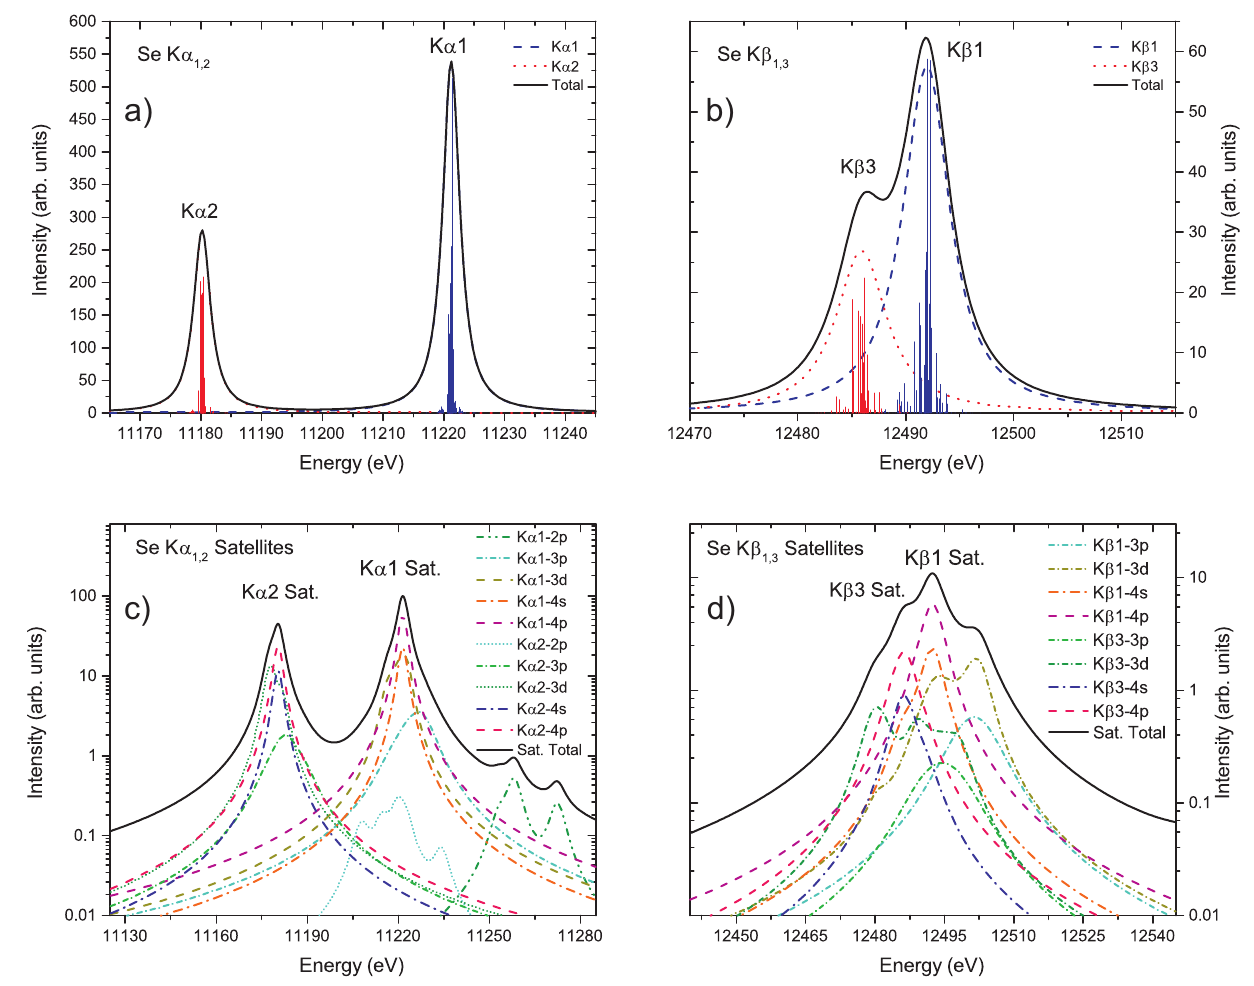
Figure 1. Simulation of the K α 1,2 ( a ) and K β 1,3 ( b ) natural line shapes of Se. The stick spectra in both plots represent the intensity and energy of individual transitions belonging to the multiplets K α 1,2 and K β 1,3 . In panels ( c ) and ( d ) the satellite lines with a spectator hole in a given subshell, arising from shake-off processes, are